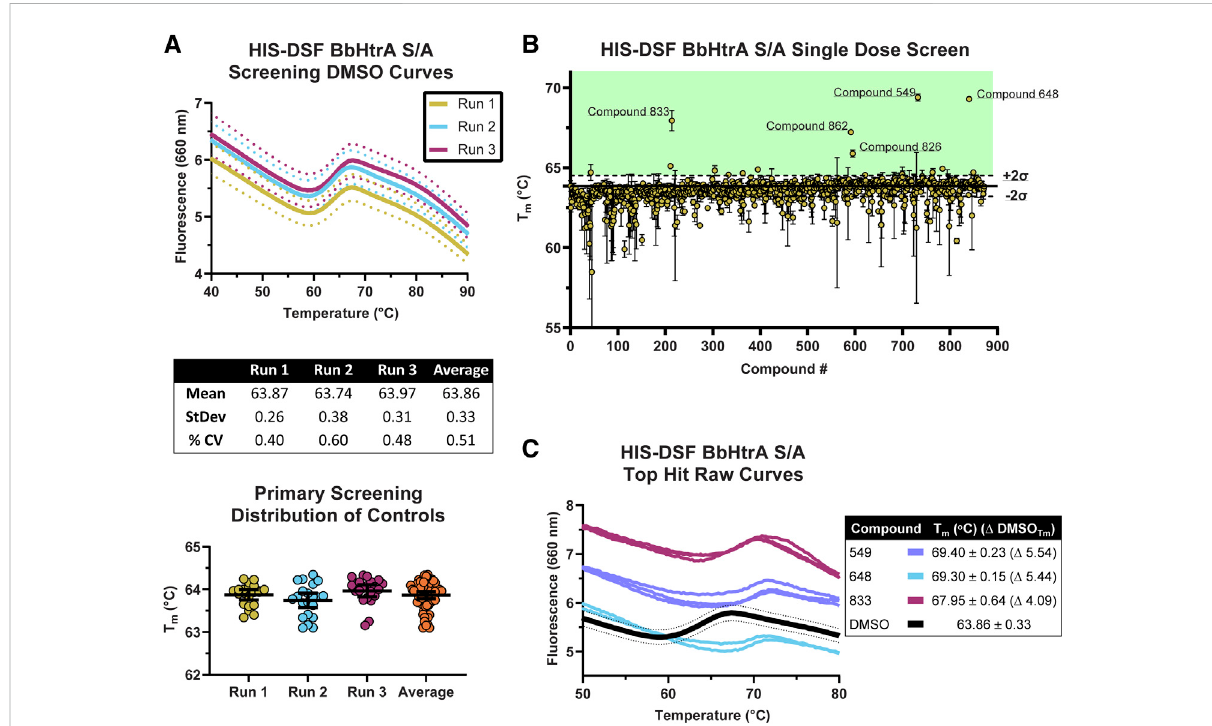
FIGURE 4 Screening of the NCATS Protease Inhibitor small molecule library using the optimized HIS-DSF assay. (A) Thermograms of the negative control DMSO wells from the three screening replicates. Each differently colored line represents the means of 24 negative control wells in a single replicate screening run with dotted lines representing the 95% con fi dence interval. Negative control wells are also clustered according to their T m for each screening run, with whisker plots representing the mean with error bars showing the 95% con fi dence interval. (B) Distribution of the T m values foreachcompoundinthesmallmoleculelibraryarrangedbymaskedcompoundID.Eachpointrepresentsthemeanofthethreescreeningrunswith error bars representing the95%con fi dence interval. The solid line represents the mean ofthe negative control DMSO wells, with dashed lines above and below representing two times the standard deviation of the negative control DMSO wells, with the green shaded area representing the area where compounds are selected for follow-up testing. (C) Thermograms of the top three hits in the HIS-DSF primary screen. Each line represents an individual replicate from each screening run, while the DMSO thermogram line represents the mean of the negative control wells with dotted lines representing the 95% con fi dence